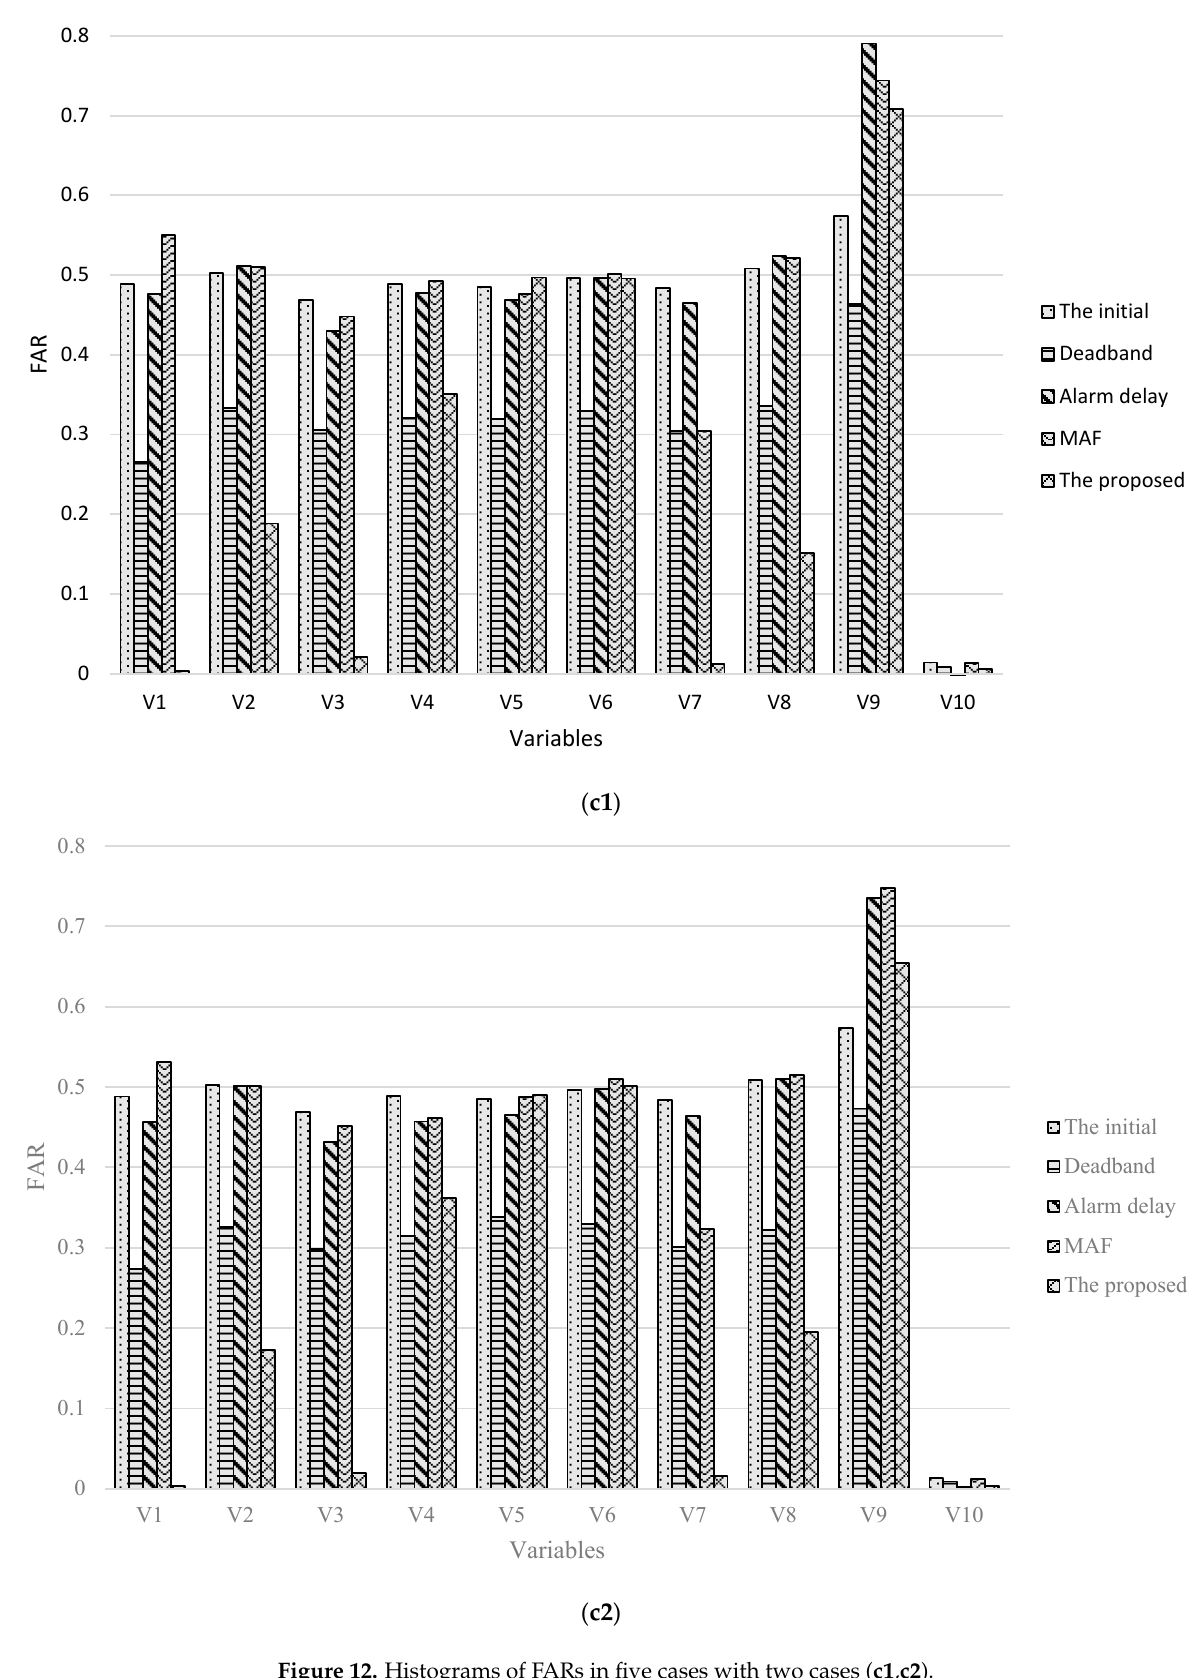
Figure 12. Histograms of FARs in five cases with two cases ( c1 , c2 ).